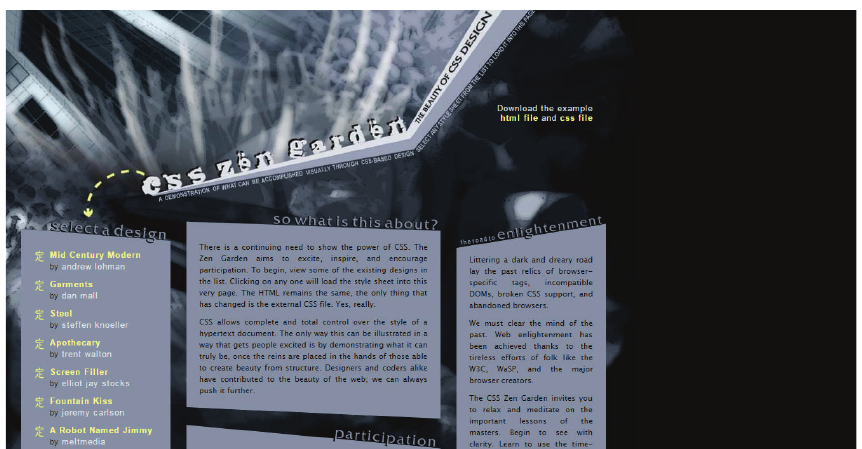
Figure 3: The first user interface used in data collection.